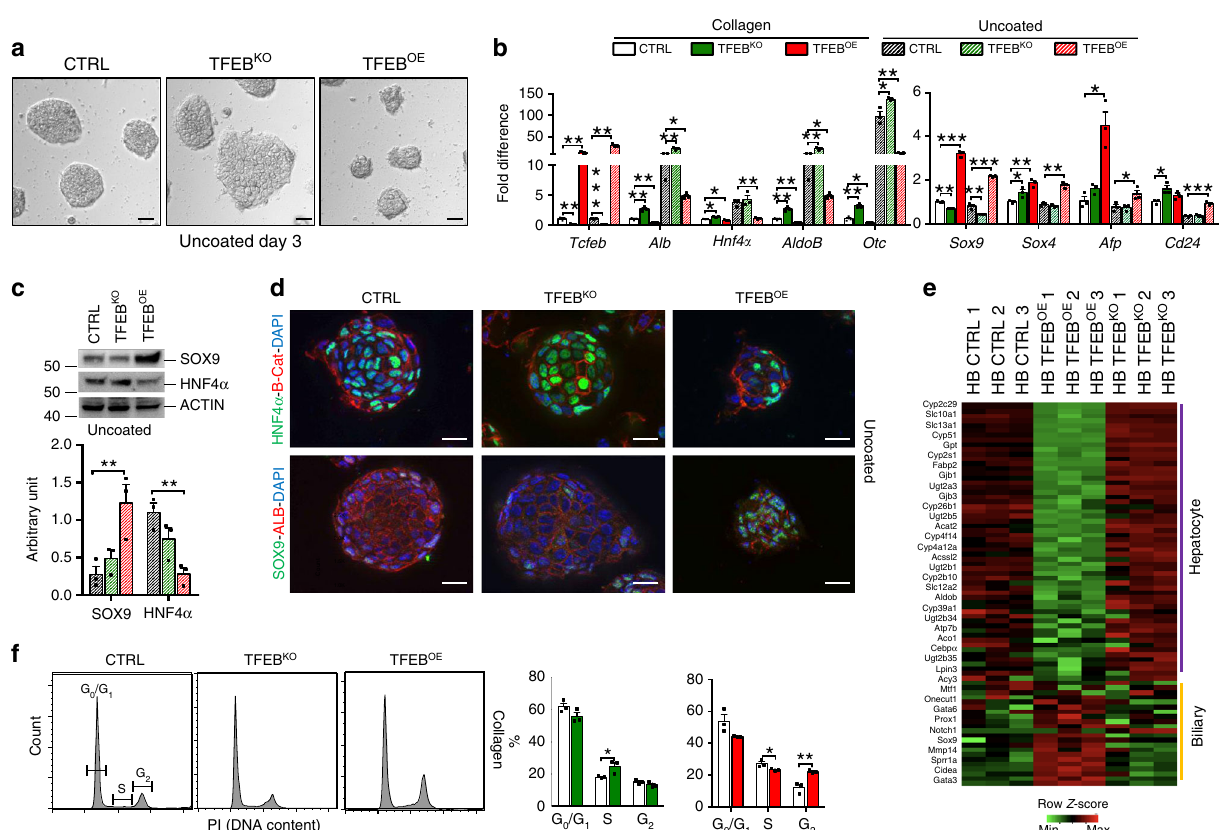
Fig. 2 TFEB in fl uences hepatoblast differentiation in vitro. a Hepatocyte sphere formation of HBs of the indicated genotypes 3 days after differentiation. Scale bar 20 μ m. Micrographs are representative of three independent experiments. b mRNA levels of the indicated genes were quanti fi ed by quantitative RT-PCR of total RNA isolated from control (CTRL), TFEB-overexpressing (TFEB OE ), and TFEB depleted (TFEB KO ) HBs undifferentiated (collagen-coated plates) or after 5 days of hepatocyte differentiation (uncoated plates). Values are indicated as mean ± SEM of n = 3 biological replicates and expressed as fold difference compared with CTRL undifferentiated HBs. c Immunoblotting analysis and relative quanti fi cation of the precursor/cholangiocyte marker SOX9 and the hepatocyte marker HNF4 α in TFEB KO and TFEB OE HBs after 5 days of hepatocytic differentiation ( n = 3 biological replicates). d Immunostaining for the indicated markers on TFEB KO and TFEB OE HBs 5 days after hepatocytic differentiation. Scale bar 5 μ m. Micrographs are representative of three independent experiments. e Gene expression pro fi ling of hepatocyte and biliary genes of differentiated HBs of the indicated genotypes. f Flow cytometry analysis of the cell cycle distribution of undifferentiated CTRL, TFEB KO and TFEB OE HBs and relative quanti fi cation ( n = 3 biological replicates). Source data are provided in the Supplementary Fig. 10. Data are represented as mean ± SEM. * p ≤ 0.05, ** p ≤ 0.01, *** p ≤ 0.001 two- tailed Student ’ s t -test. Source data are provided as a Source Data fi